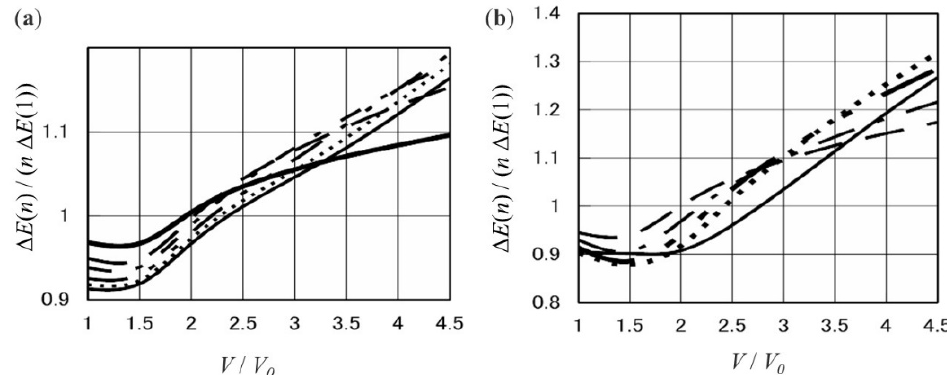
Figure 13. Velocity dependence of energy-loss ratio per atom for a C n ( n = 2 − 10 ) cluster ion in linear ( a ) chain and ( b ) ring structures, penetrating a carbon foil of 26.5 nm thickness: (left) thick solid line ( n = 2), broken line ( n = 3), dot-dashed line ( n = 4), dot-dot-dashed line ( n = 6), dotted line ( n = 8), thin solid line ( n = 10), (right) broken line ( n = 3), dot-dashed line ( n = 4), dot-dot-dashed line ( n = 6), dotted line ( n = 8), and thin solid line ( n = 10) [14].